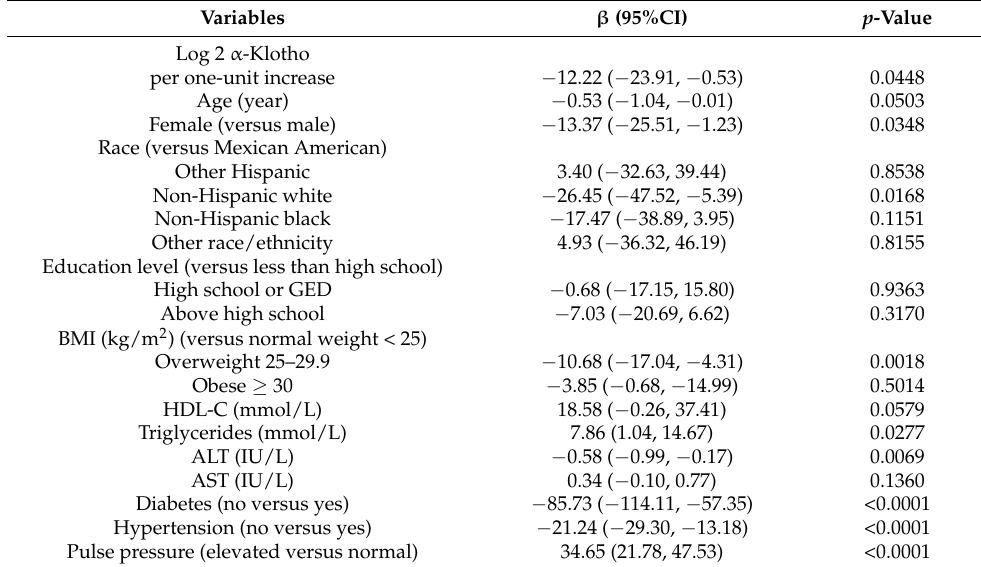
Table 3. Multivariate logistic regression models of ACR.